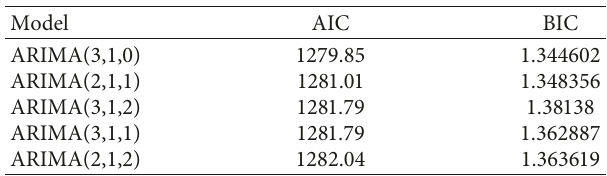
Figure 2: (a) Time series for weekly registers. (b) Autocorrelation function of the time series. Table 1: Models fitted to the data.